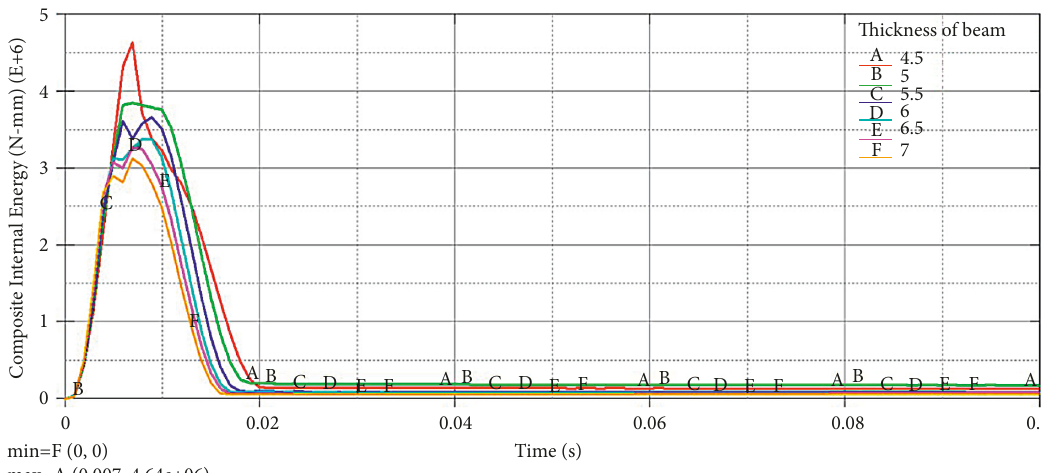
Figure 12: Internal energy of different thicknesses.